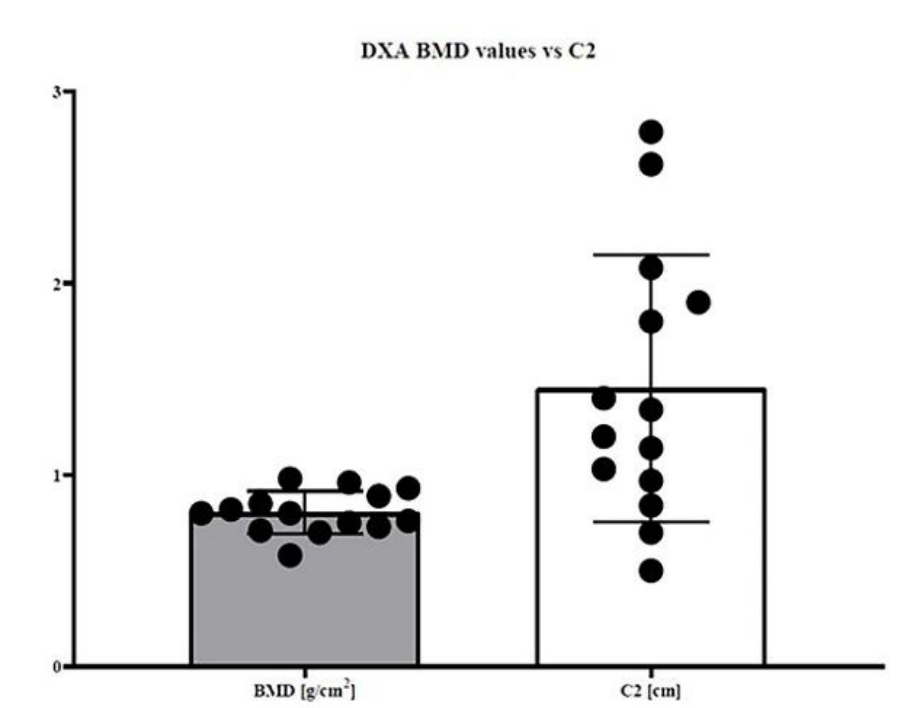
Figure 6. Fourth dataset (the BMD value measured using the Double Energy X-ray Absorptiometry (DEXA) technique compared to the C2 value of the population affected by OI alone) in the Welch–Satterthwaite p -value of 0.0042.